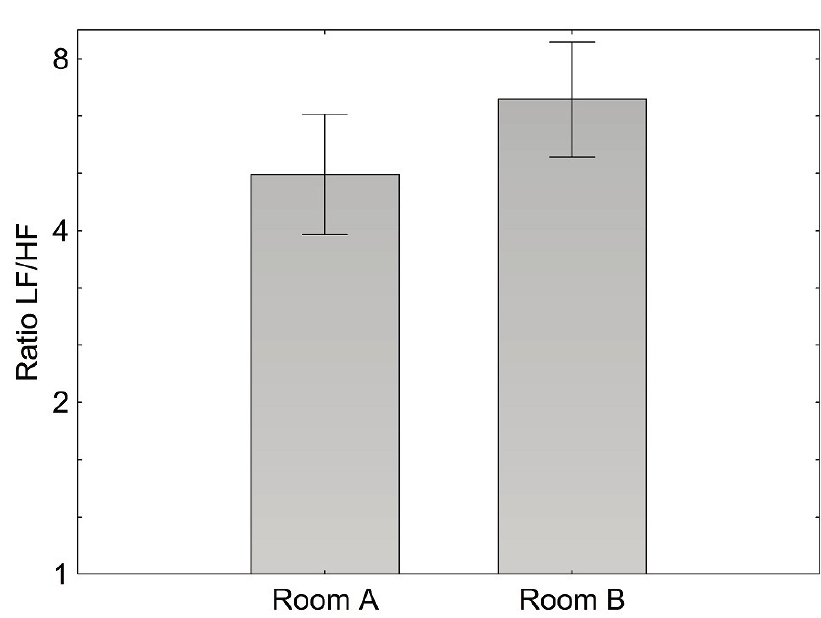
Figure 1. Means and confidence interval of log ratio of the low to the high frequency component (LF/HF) during 20 min standardized activity while seated in room A and